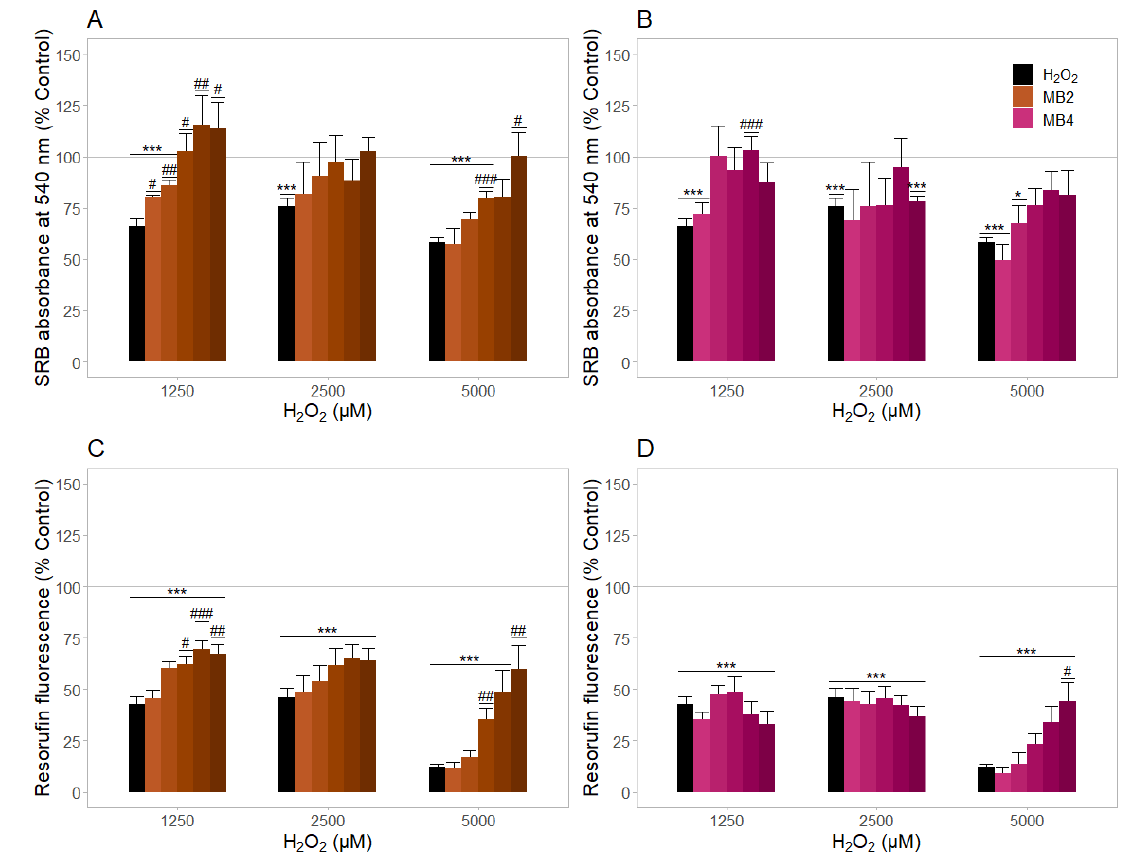
Figure 6. Protective effects of MB2 and MB4 against oxidative stress-induced cytotoxicity on cell mass ( A , B ) and metabolic activity ( C , D ) of normal human dermal fibroblasts (NHDFs). Normal human dermal fibroblasts were treated with MB2 and MB4 at concentrations between 1.0, 3.2, 6.3, 12.5 and 25.0 µ M for 48 h. Three hours before measuring cellular mass and metabolic activity, cells were treated with increasing concentrations of H 2 O 2 (1250, 2500 and 5000 µ M). Cellular mass and metabolic activity were evaluated using the sulforhodamine B (SRB) assay and resazurin reduction assay, respectively. Data are the mean ± SE of four independent experiments. Results are expressed as percentage of the control (antioxidant vehicle-treated cells). Statistically significant differences between control and treated groups or between H 2 O 2 (no antioxidants) and treated groups were evaluated using a t -test. *** p < 0.001 and * p < 0.05 compared to the respective control without antioxidant. ### p < 0.001, ## p < 0.01 and # p < 0.05 compared to the respective control treated with H 2 O 2 without antioxidant.